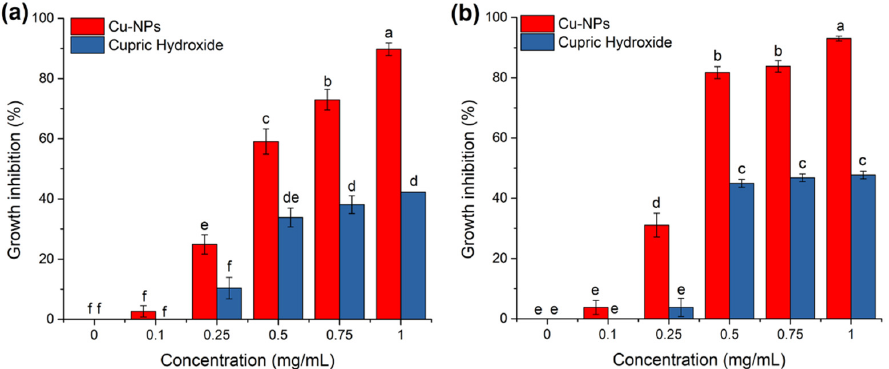
Figure 2. The mycelial radial growth inhibition percentage from F. kuroshium was quantified at ( a ) 3 and ( b ) 6 dai in both treatments, Cu-NPs, and cupric hydroxide, respectively. A one-way ANOVA with a Tukey’s test was used to determine significance across all the treatments. Different letters on top of the bars indicate significant differences ( p ≤ 0.01). Error bars represent the standard error ( n = 3).